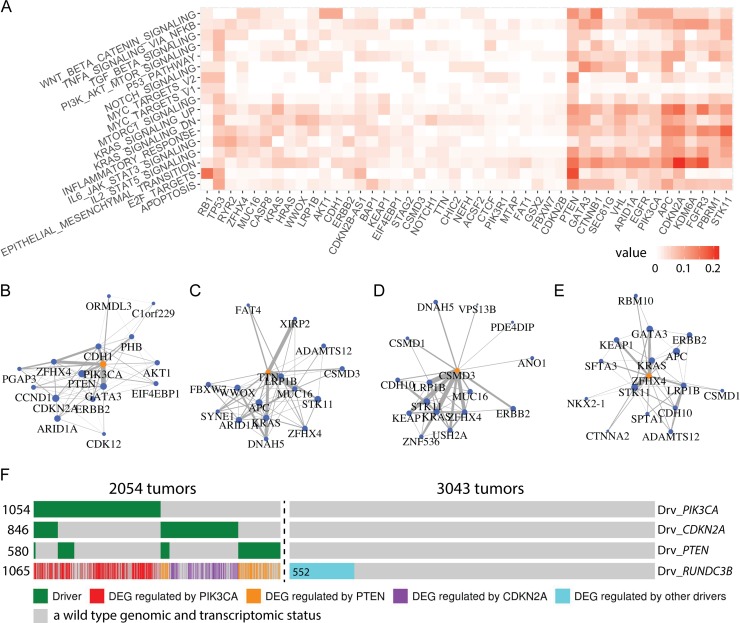
Detection of functional impact of SGA-FIs reveals functional connections among SGA-FIs.A. Top 45 SGAs-FIs (regulating the largest number of DEGs) and their relationships with 17 cancer hallmark gene sets. The value in a cell represents the fraction of genes in a hallmark gene set that is covered by the target DEGs of each SGA-FI. B-E. Top 15 SGA-FIs that share the most significant overlapping target DEGswith PIK3CA, TTN, CSMD3, and ZFHX4. An edge between a pair of SGA-FI indicate that they share significantly overlapping target DEG sets, and the thickness of the line is proportional to negative log of the p-values of overlapping target DEG sets. F. An “oncoprint” illustrating the causal relationships between the DEG RUNDC3B and its 3 main drivers according to TCI, namely, PIK3CA, CDKN2A, and PTEN. Each column corresponds to a tumor; green bars indicate tumors in which TCI designated each of the three SGA genes as a driver, regardless of what DEGs it was driving in a given tumor. The causal relationship is color-coded, which illustrates which SGA-FI is predicted by TCI to cause the RUNDC3B DEG event; the blue bar indicates the DEG events that were assigned to SGA-FIs other than the above 3 SGA-FIs; gray bars indicate a wild type genomic and transcriptomic status.